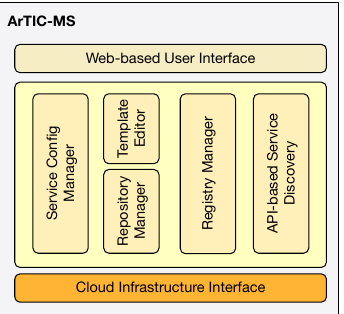
Figure 8. Preliminary version of